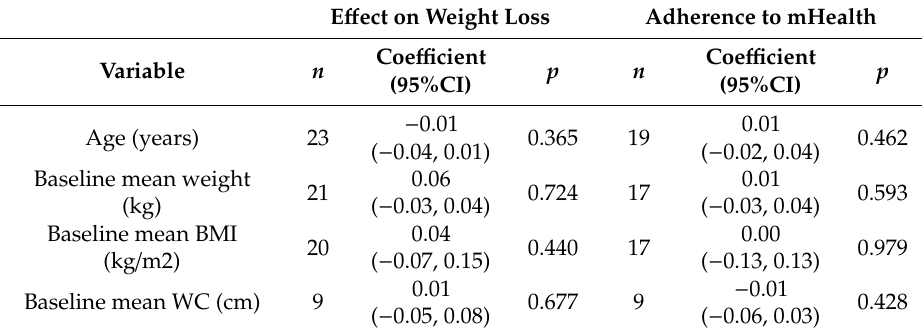
Table A2. Random-e ff ects meta-regressions for the e ff ects of age, weight, BMI and WC on the pooled e ff ect on weight loss and adherence to